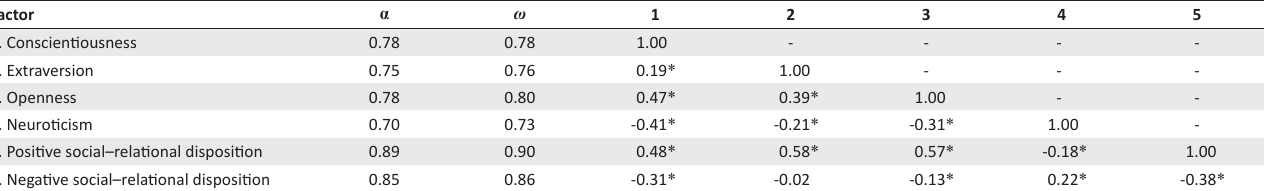
TABLE 5: Correlations coefficients of the South African Personality Inventory factors. Factor